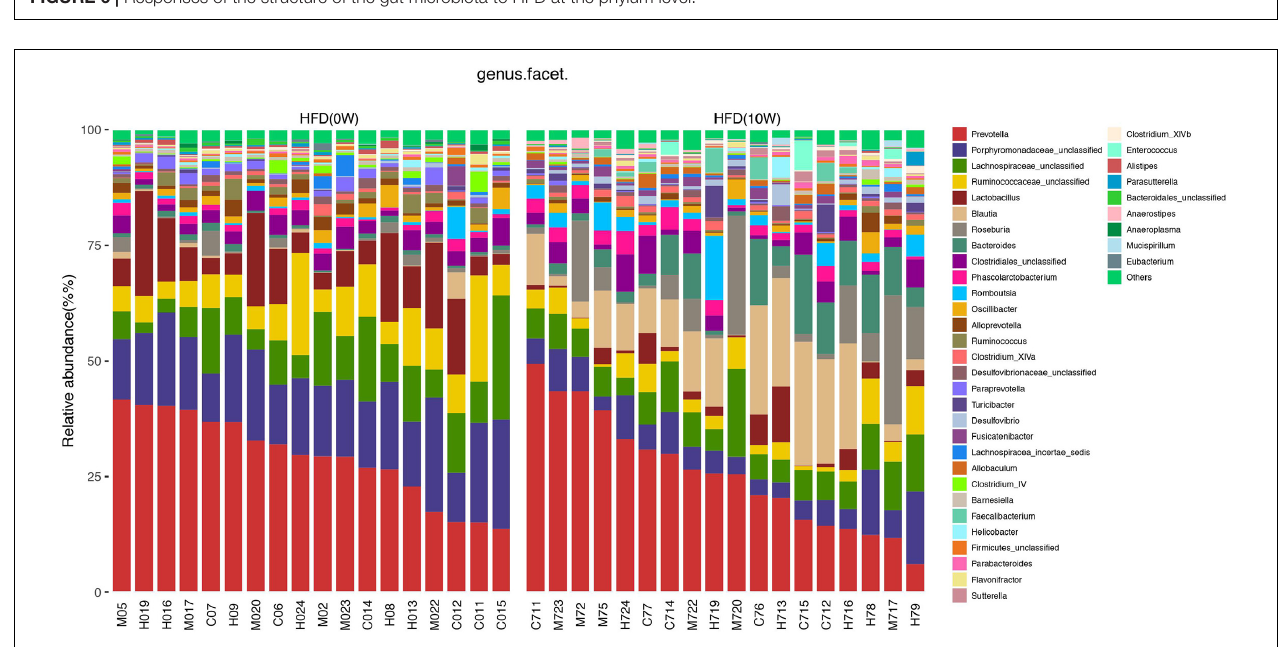
FIGURE 6 | Responses of the structure of the gut microbiota to HFD at the phylum level.